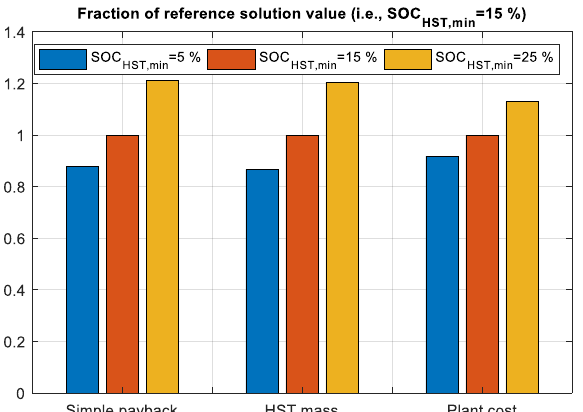
Figure 7. Comparison between three renewable rSOC microgrid configurations resulting from the application of the constrained optimization algorithm to three scenarios, each one characterized by a different c 3 constraint (see Section 3.2).